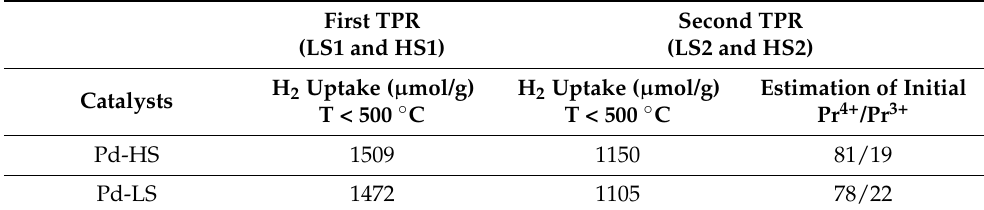
Table 2. H 2 consumption during H 2 -TPR and Pr 4+ /Pr 3+ ratios.